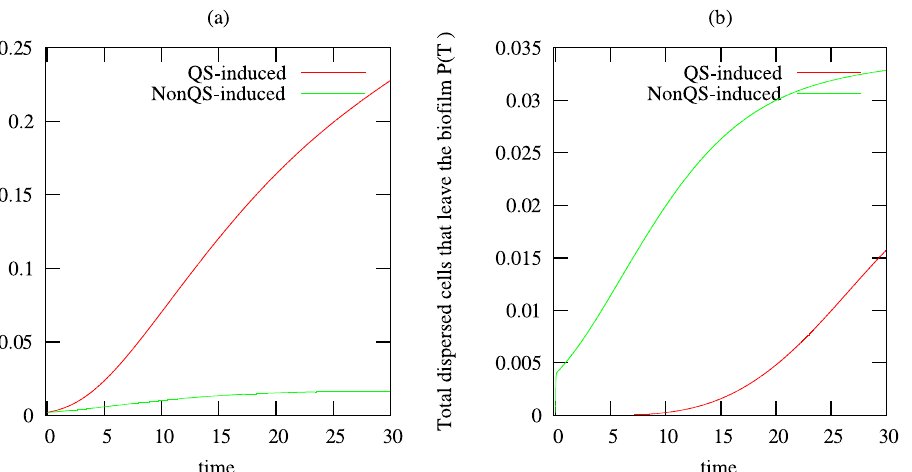
Fig 5. Temporal simulations results to investigate the re-attachment of bacterial cells after dispersal. Shown are (a) the ratio of dispersed cells that are re-attached and the cells that are detached Z(t) using τ L = 10 nM , τ H = 70 nM , η 1 L = 0.6/ d , η 1 H = 4.2/ d ; (b) amount of re-attached cells defined by Z 2 M computed for different values of k 5 i.e. k 5 = 0.1, 0.2, 0.3, 0.4, 0.5, 0.6, 0.7 gm − 3 using the quorum sensing threshold value τ = 10 nM and the maximum dispersal rate η 1 = 3.6 d − 1